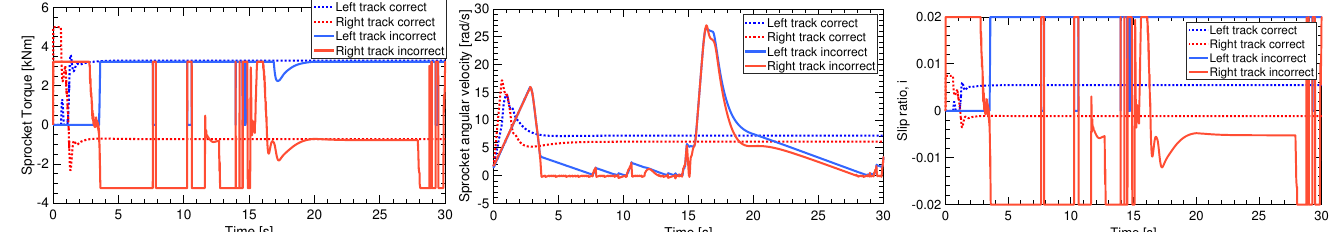
Figure 27. Trajectory following test (circular path) in case of incorrect tractive force estimation: torque behavior ( left ), sprocket rotational velocity ( middle ), and slip of the track ( right